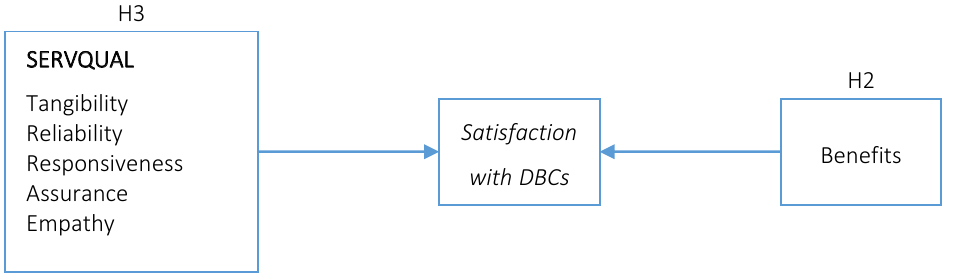
Figure 1. Impact of SERQUAL and benefits on satisfaction with